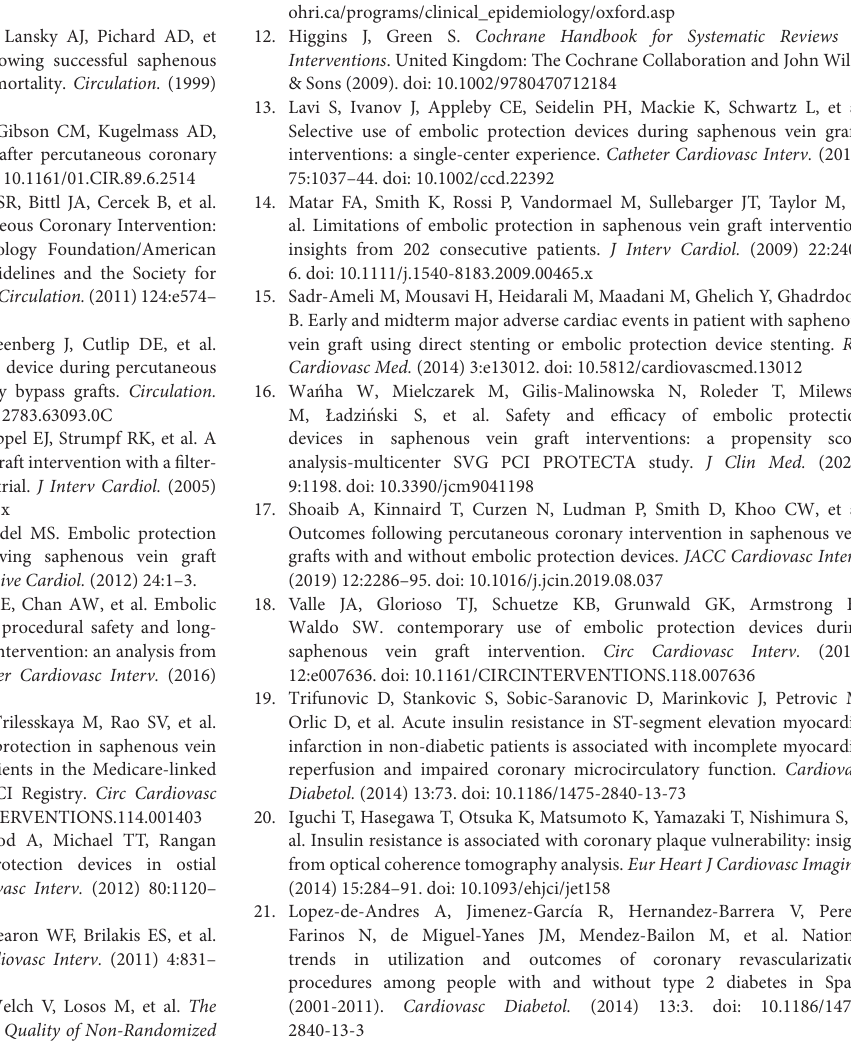
Supplementary Figure 1 | Funnel plot for checking publication bias for mortality